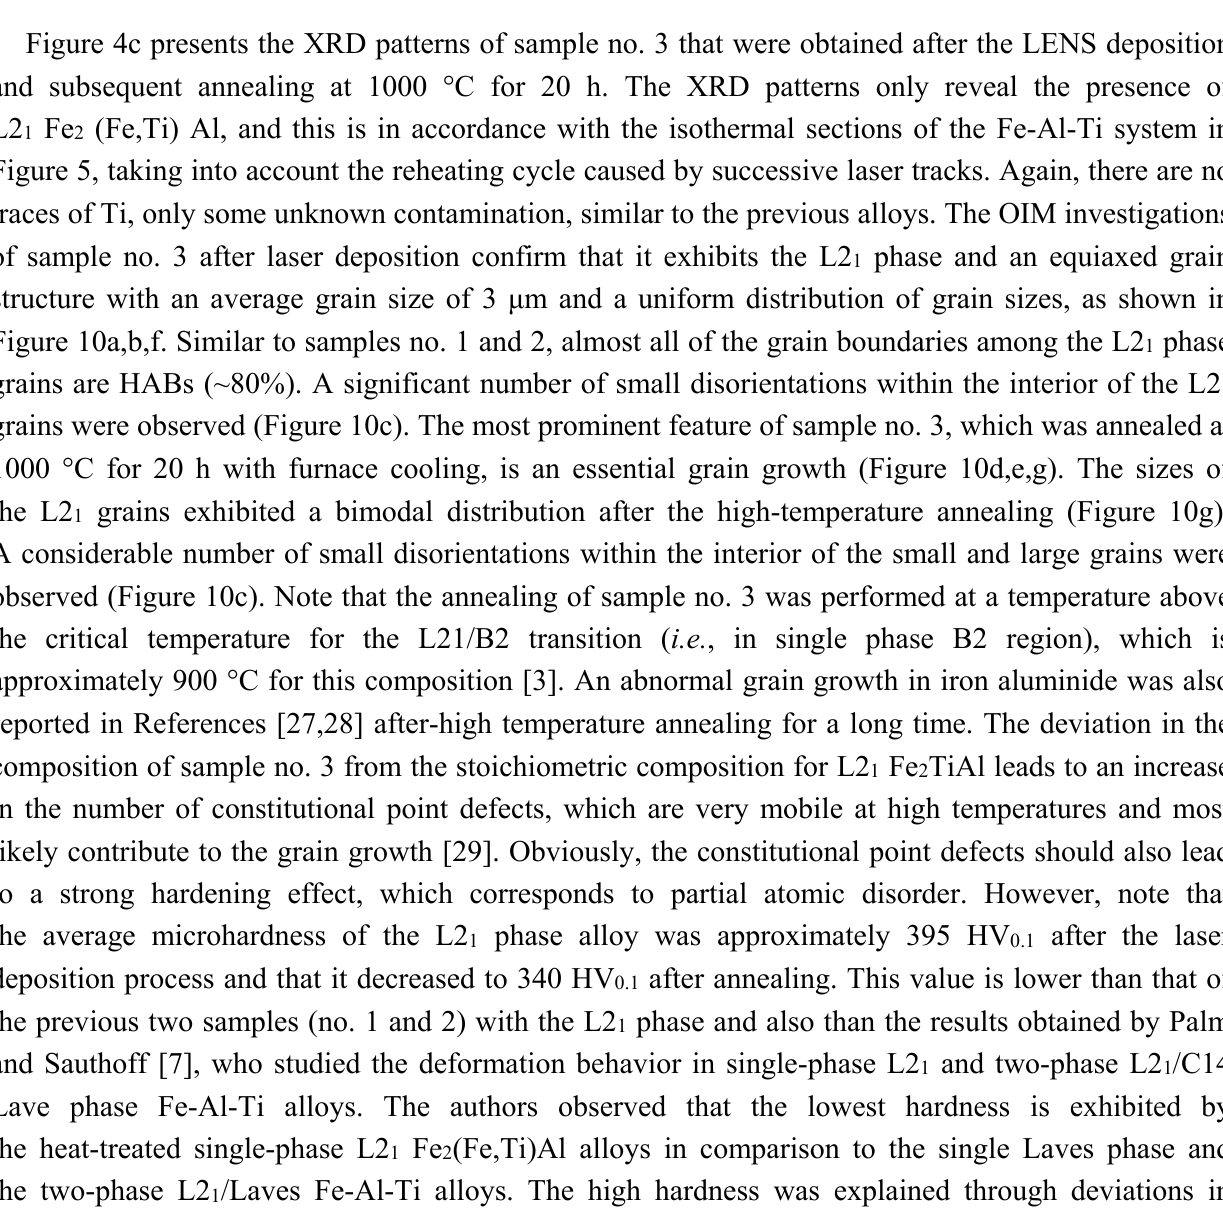
Figure 9. ( a ) BSE image of sample no. 2 after laser deposition and annealing at 1000 °C for 20 h; ( b ) linear EDS analysis of Fe, Al and Ti along the line in figure ( a